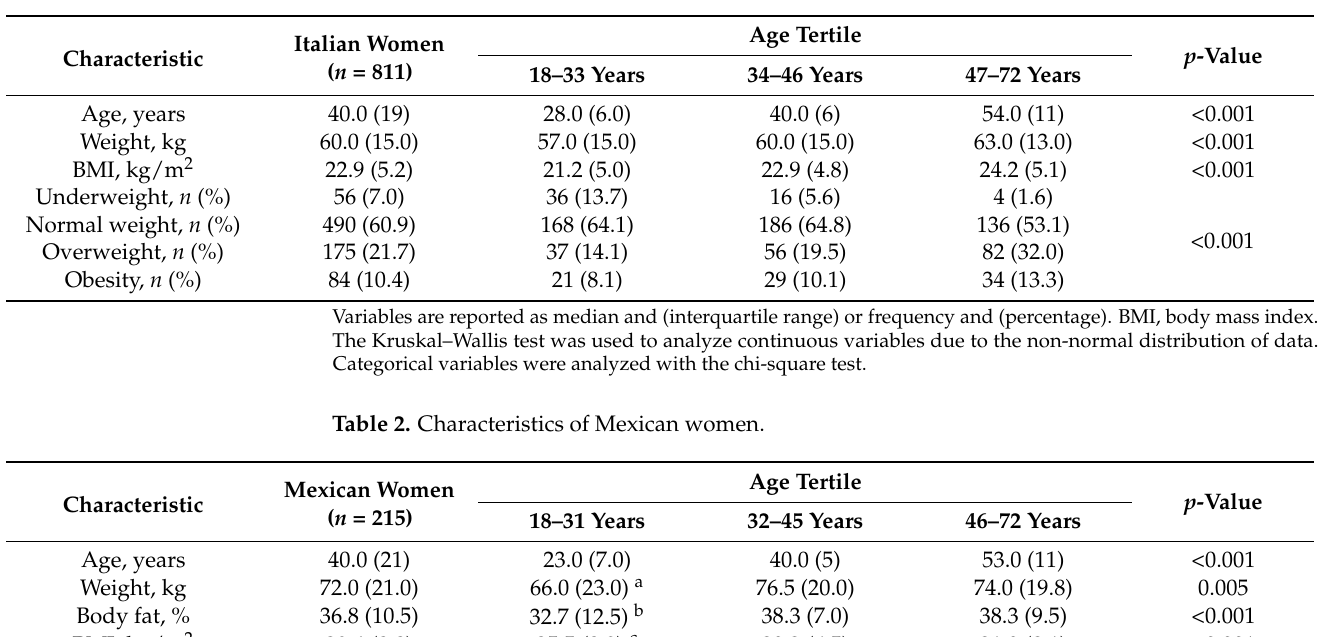
Table 1. Characteristics of Italian women.